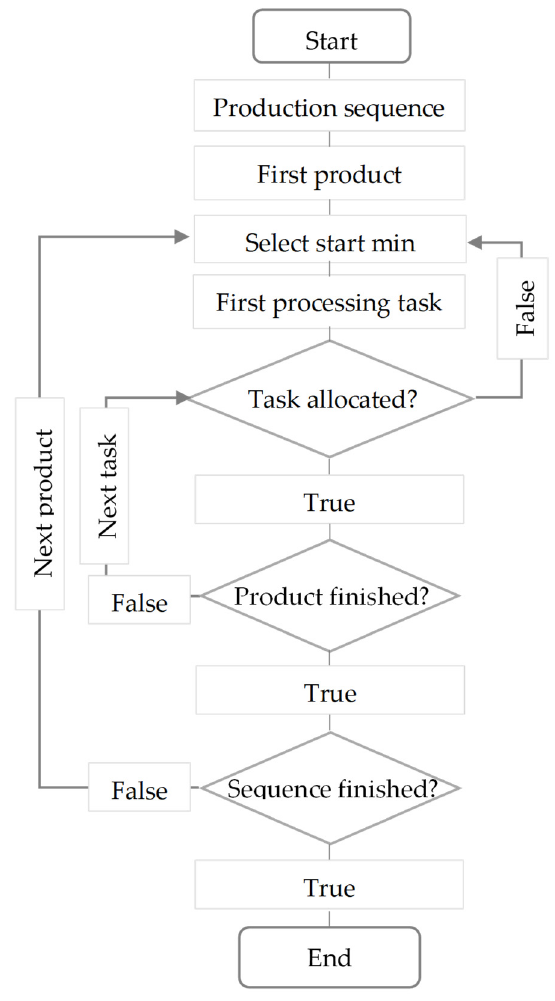
Figure 3. Scheduling procedure of hybrid NWFSSM.